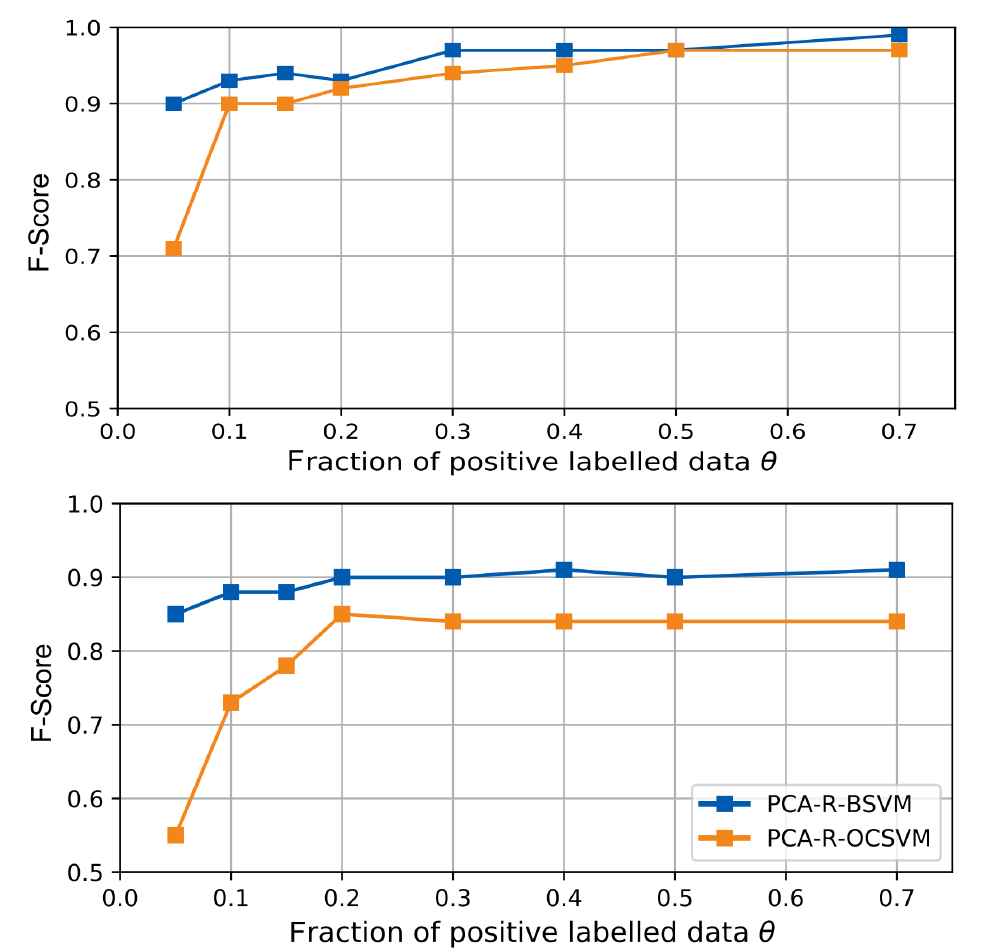
Figure 4. Accuracy plot over fraction of positive labelled samples: models trained on - upper: screw chiller dataset, lower: centrifugal chiller